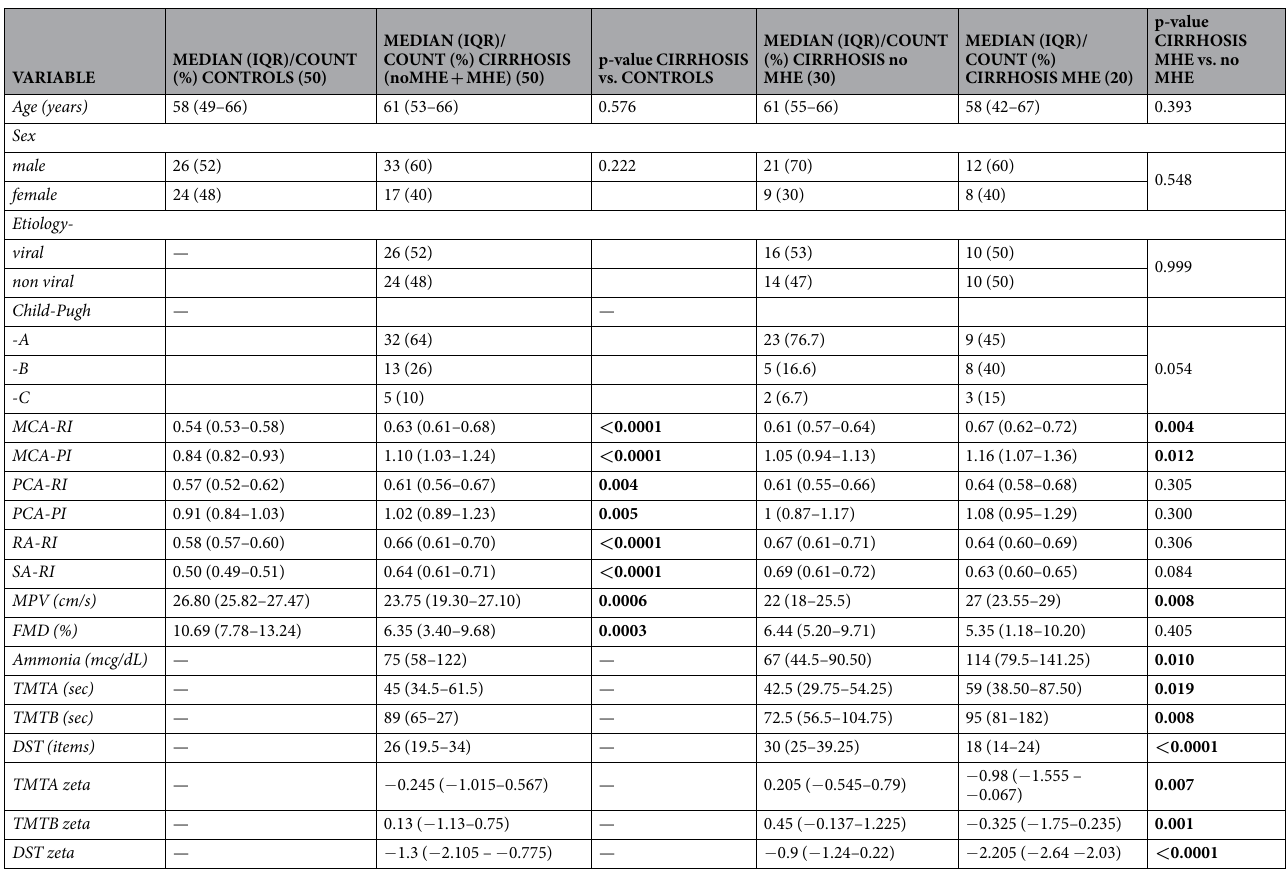
Table 1. Clinical and demographic characteristics of the cirrhotic patients and healthy controls included in the study. RI = resistive index; PI = pulsatility index; MCA = middle cerebral artery; PCA = posterior cerebral artery; RA = renal artery; SA = splenic artery; MPV = mean portal vein velocity; FMD = flow mediated dilation; TMT = trail making test; DST = digit symbol